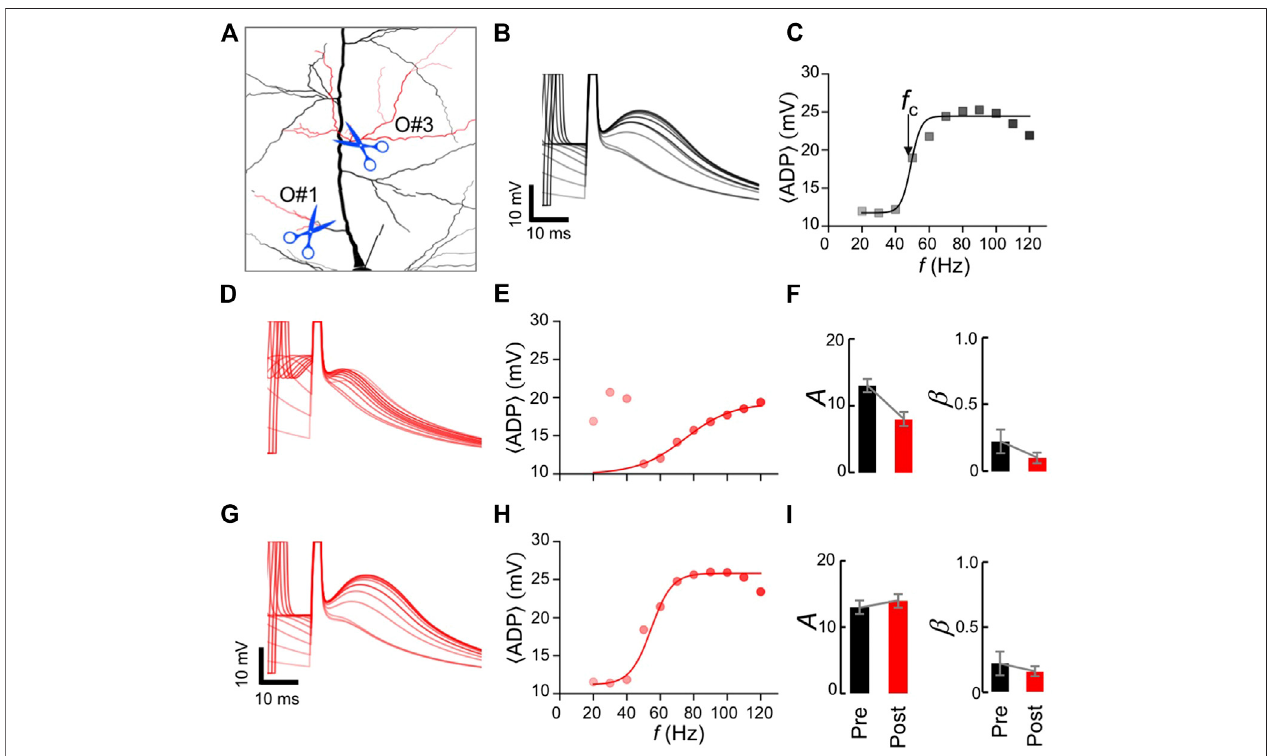
FIGURE 4 | Numerical dendrotomy of oblique branches: (A) A magni fi ed view of the L5PN model following dendrotomy of oblique branches O#3 or O#1 (red). (B) Somatic traces during a two-AP train, and (C) corresponding frequency response of the ADP before dendrotomy. (D) Somatic traces after cutting O#3 and (E) correspondingfrequency response ofthe 〈 ADP 〉 . (F) Quanti fi cation ofthechangesin fi ttingparameters, amplitude (A) and slope ( β ),ofthe Sigmoid function before (Pre) and after (Post) dendrotomy. Cutting oblique branch O#1 and corresponding (G) somatic traces during a two-AP train, and (H) the frequency response of the 〈 ADP 〉 (I) Changes in A and β after cutting O#1. The error bars show uncertainty of the Sigmoid fi t.